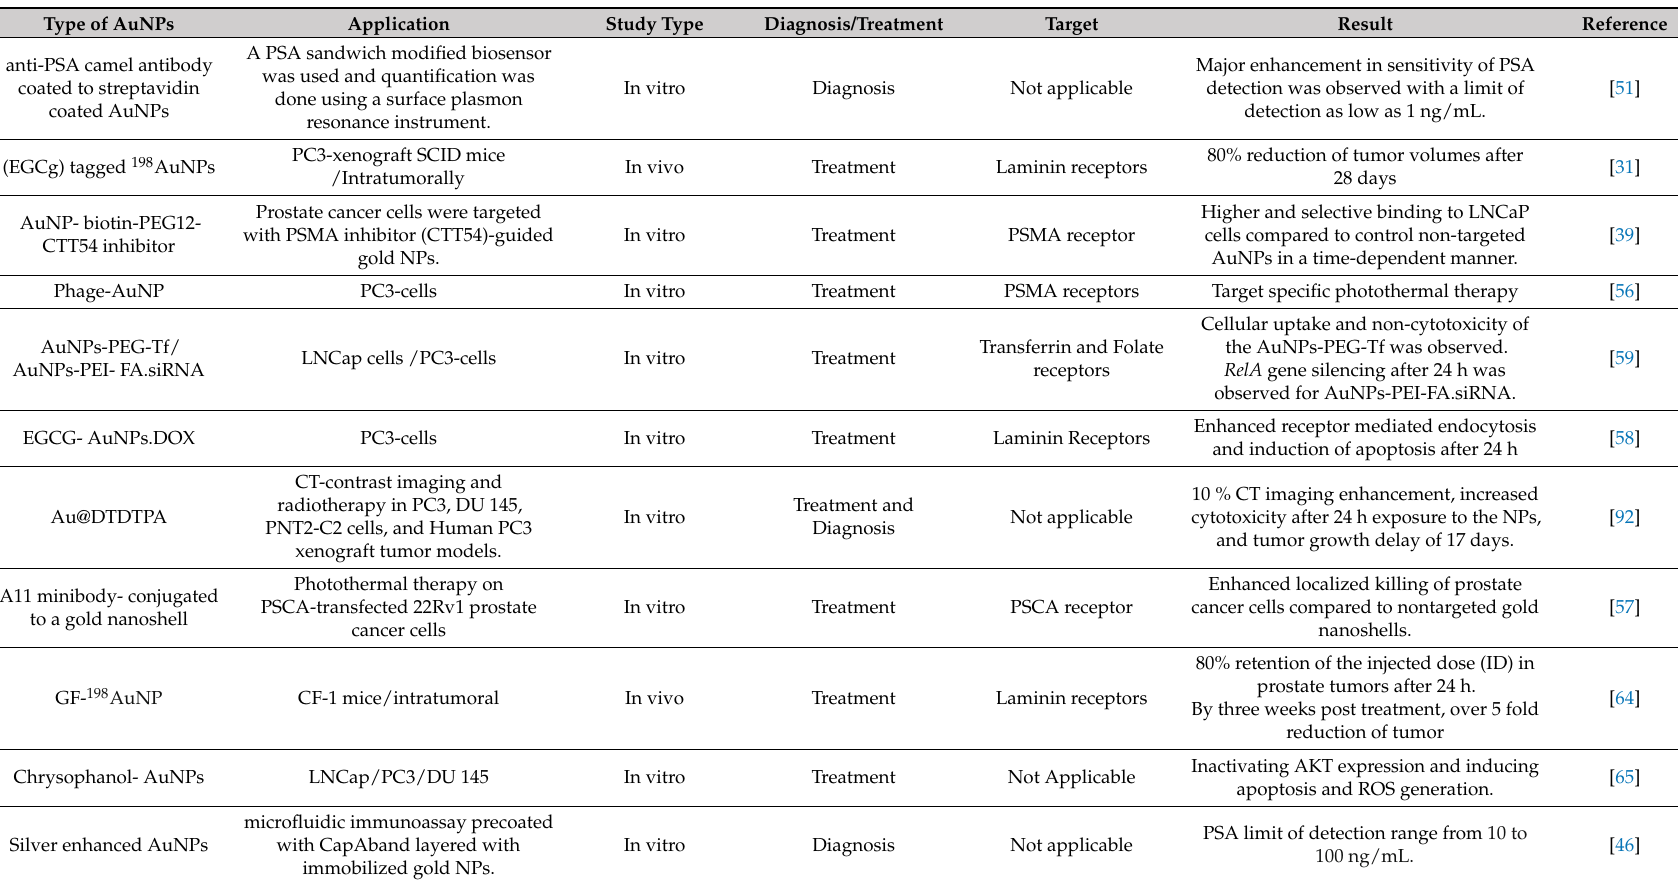
Table 3. Summary of the gold nanoparticles employed for the targeted therapy or diagnosis of prostate cancer. The table summarizes the novel strategies employed for prostate cancer theranostics using gold nanoparticles in a chronological order